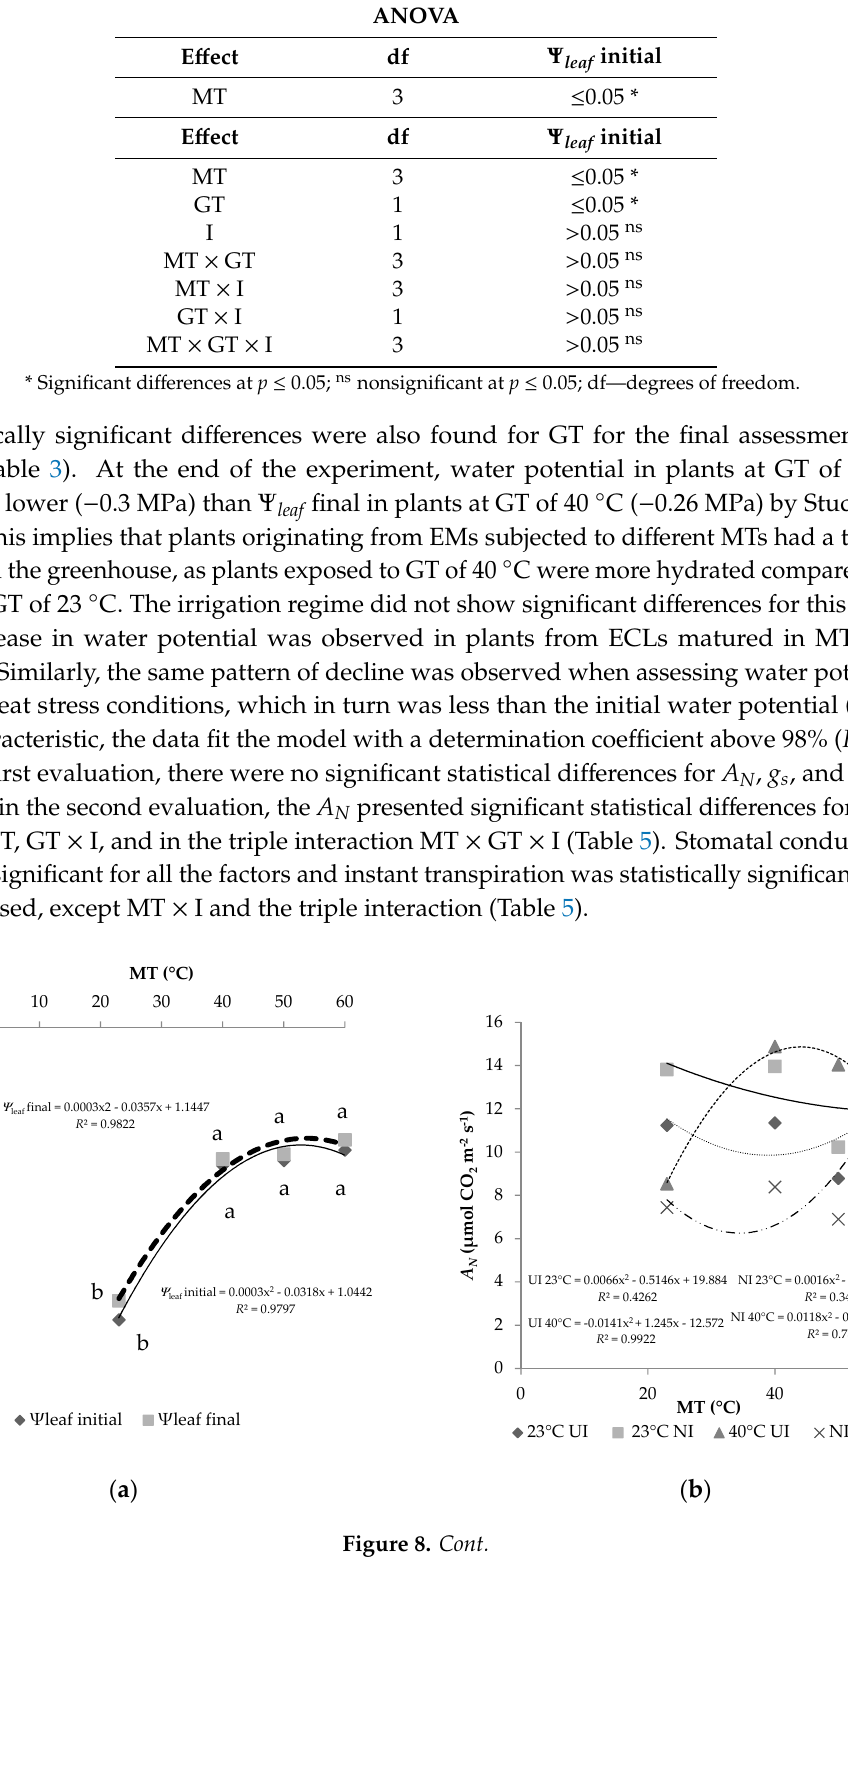
( d ) Figure 8. Water potentials and gas exchange parameters in plants with greenhouse temperature (23 or 40 °C) under (UI) irrigation or no irrigation (NI) conditions (I) obtained from EMs of Pinus radiata D.Don submitted to different maturation temperatures (MT). ( a ) Leaf water potentials ( Ψ leaf ) initial and final (applying of these treatments), ( b ) instantaneous net photosynthesis ( A N , µmol CO 2 m − 2 s − 1 ), ( c ) stomatal conductance ( g s , mmol H 2 O m − 2 s − 1 ), and ( d ) instant transpiration ( E , mmol H 2 O m − 2 s − 1 ). Different letters show significant differences by the Tukey–Kramer test ( p ≤ 0.05). In the first evaluation, there were no significant statistical differences for A N , g s , and E (Table 4). By contrast, in the second evaluation, the A N presented significant statistical differences for the effects MT, MT × GT, GT × I, and in the triple interaction MT × GT × I (Table 5). Stomatal conductance was